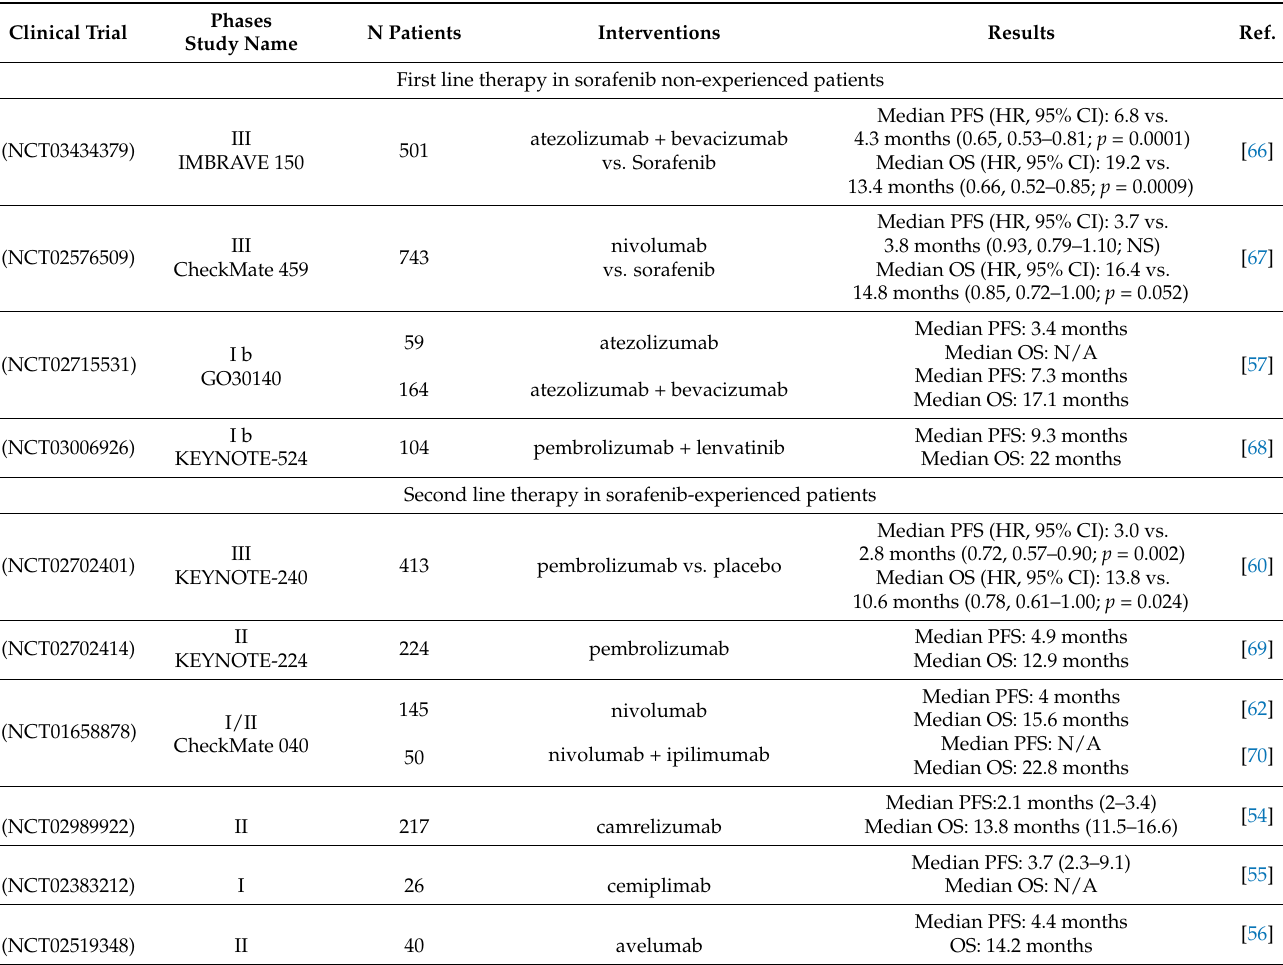
Table 1. List of the main phase II and III clinical trials for administration of immunotherapy in the context if